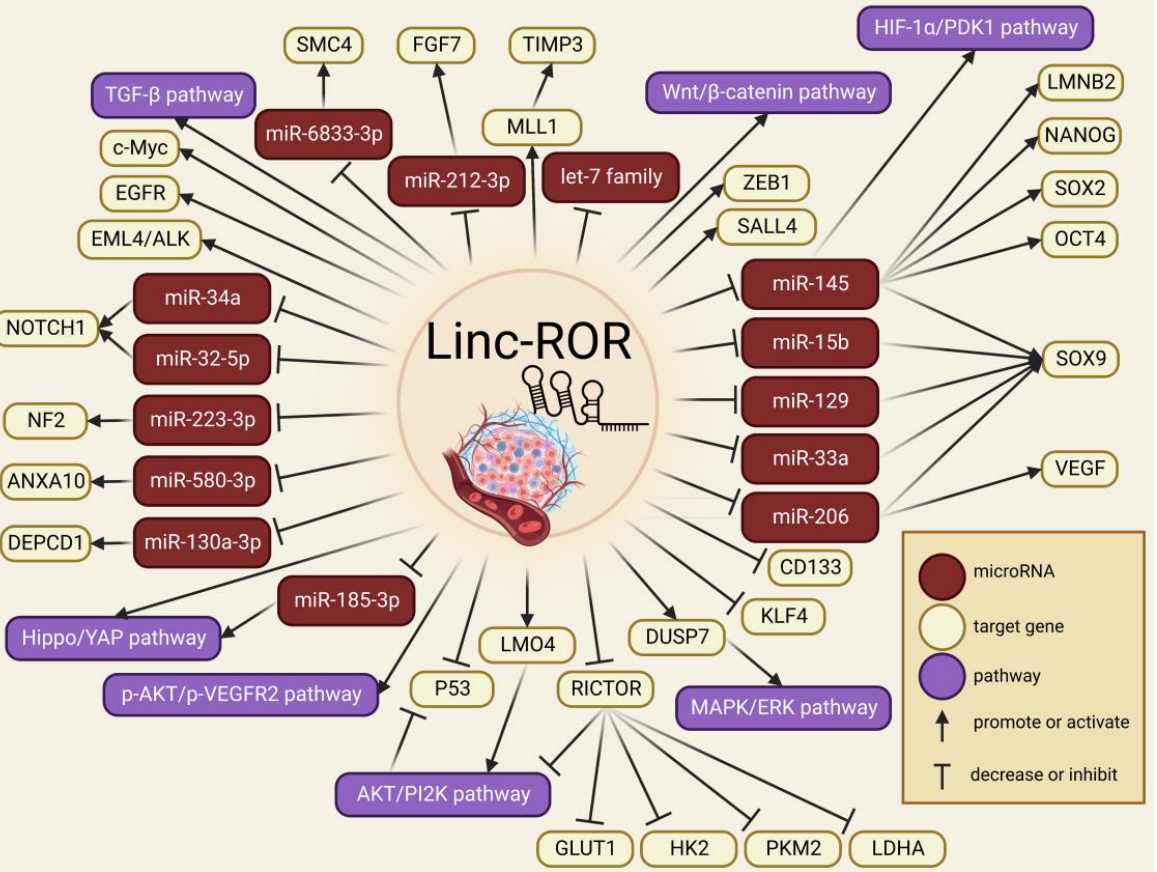
Figure 1. Overview of the molecular mechanisms by which linc-ROR participates in cancer prolifera- tion and